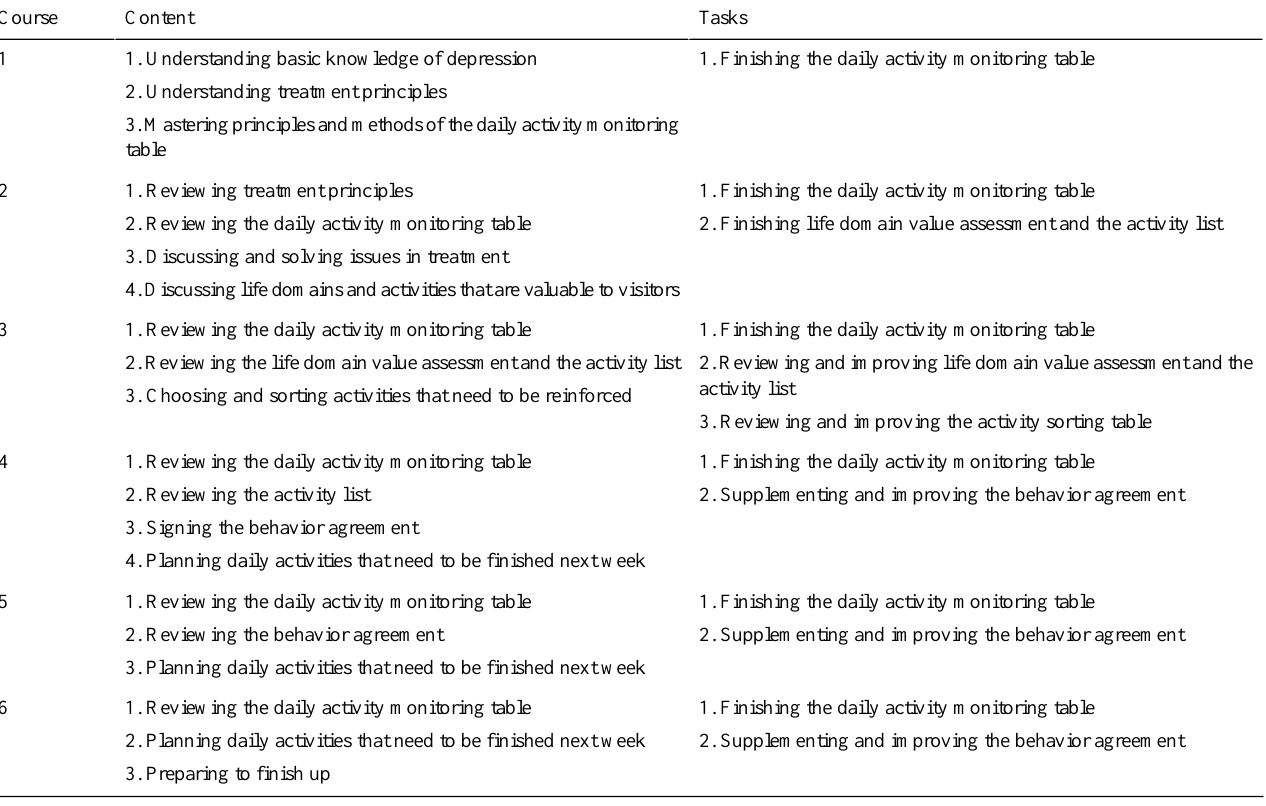
Table 1. Establishment of the treatment courses of behavioral activation therapy.